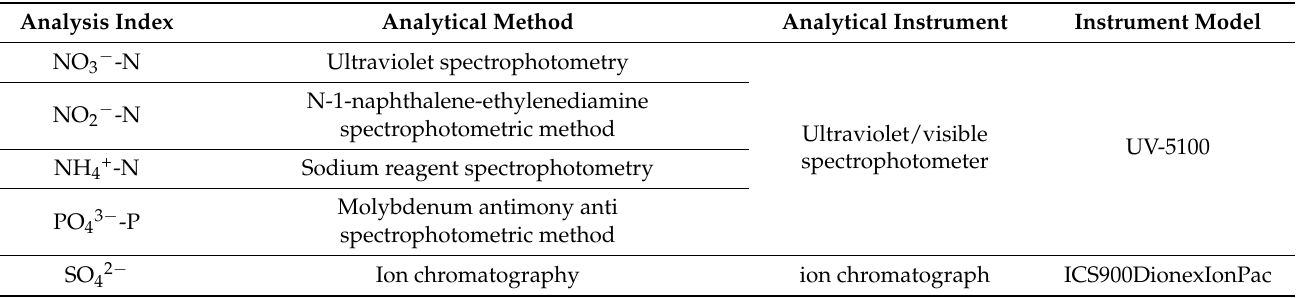
Table 1. Water-quality analysis